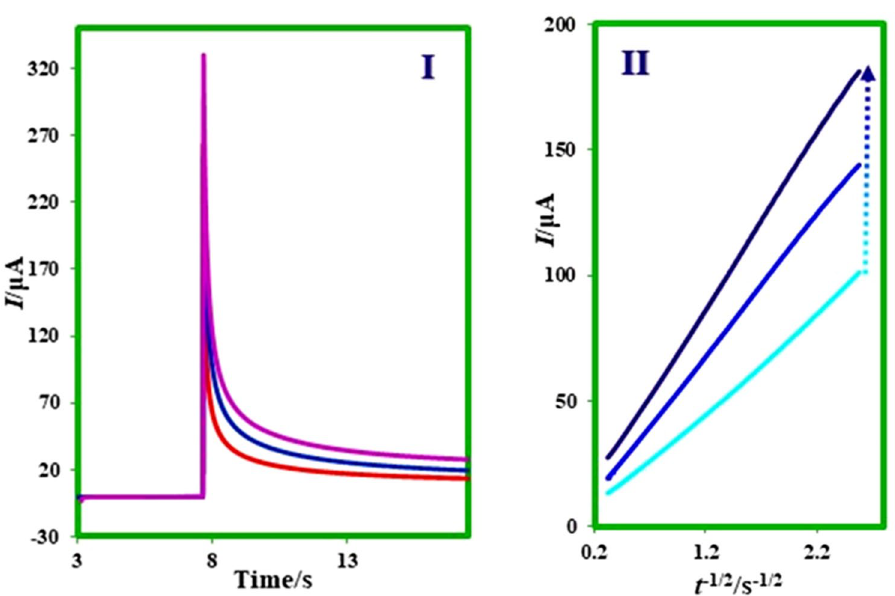
Figure 8.. ( I ) Chronoamperograms of MFA at the surface of glassy carbon electrode in ethanol containing MgClO 4 (1.0 M) in various concentrations of MFA . Concentrations from a to c are 3.0, 5.0, and 7.0 mM. The potential of 0.95 V versus Ag/AgCl was applied for 10 s. ( II ): I − t 1/2 plot of MFA for the corresponding point in chronoamperogram I . Room temperature.